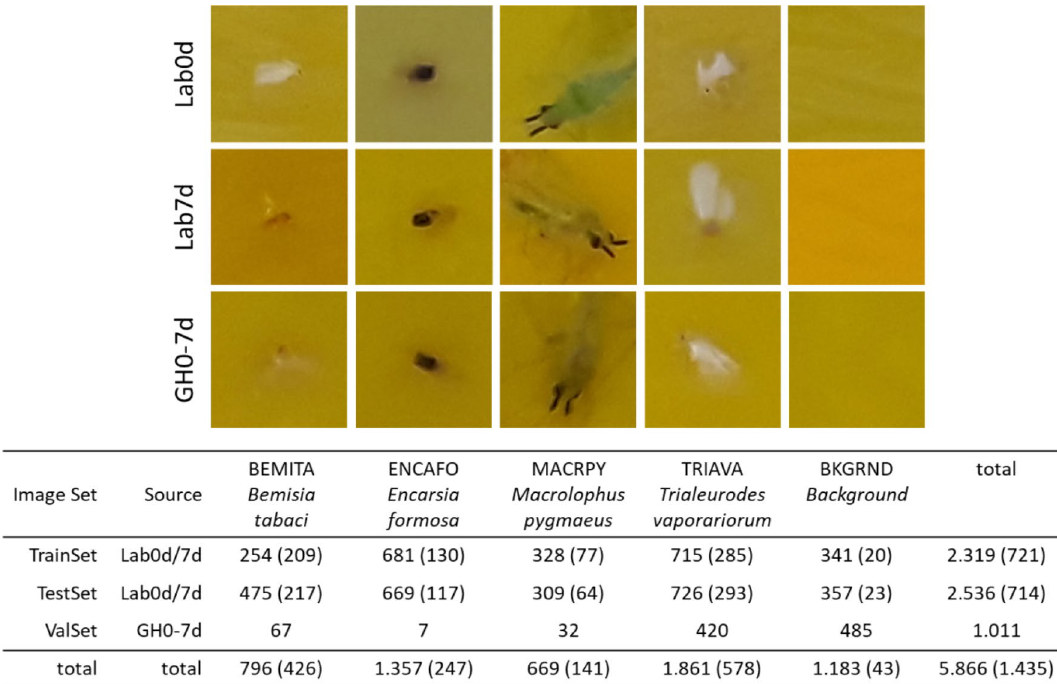
Figure 6. Overview of the sub-images and trained categories for the Lab0d and Lab7d datasets. The table shows the number of images provided in the corresponding datasets for training (TrainSet), testing (TestSet) and validation (ValSet). For the Lab7d dataset, the values are shown in